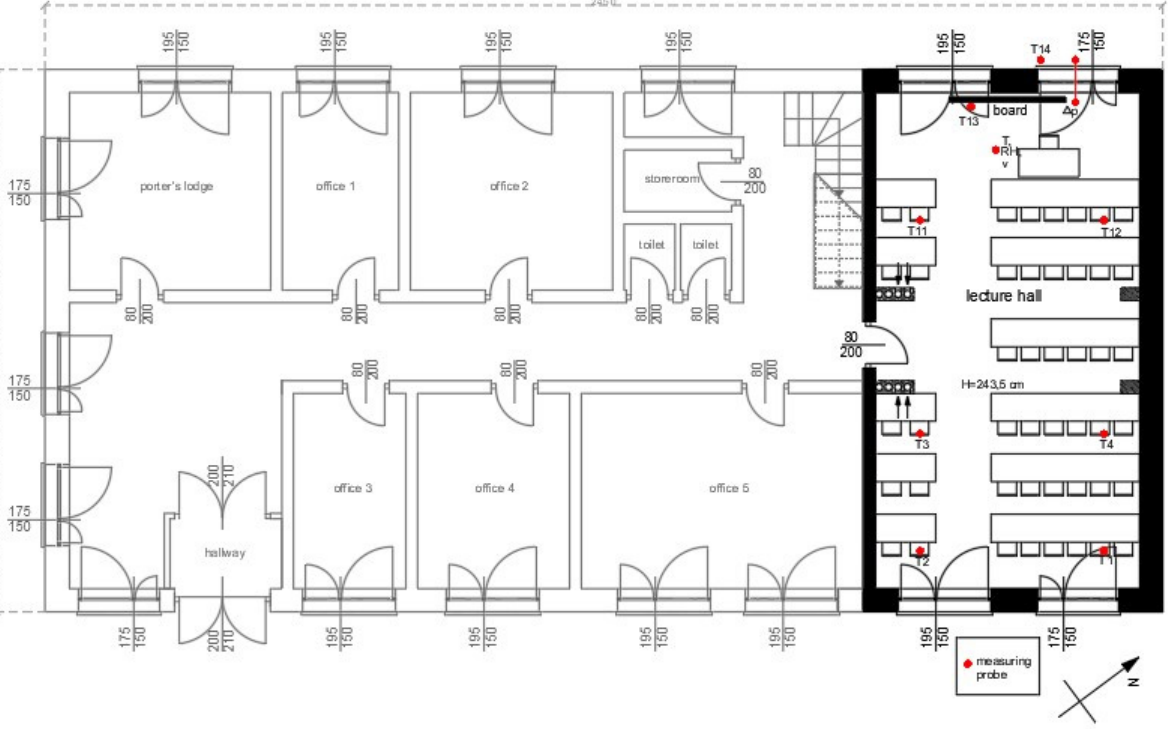
Figure 3. Plan of the building floor with lecture room with the location of measuring probes.